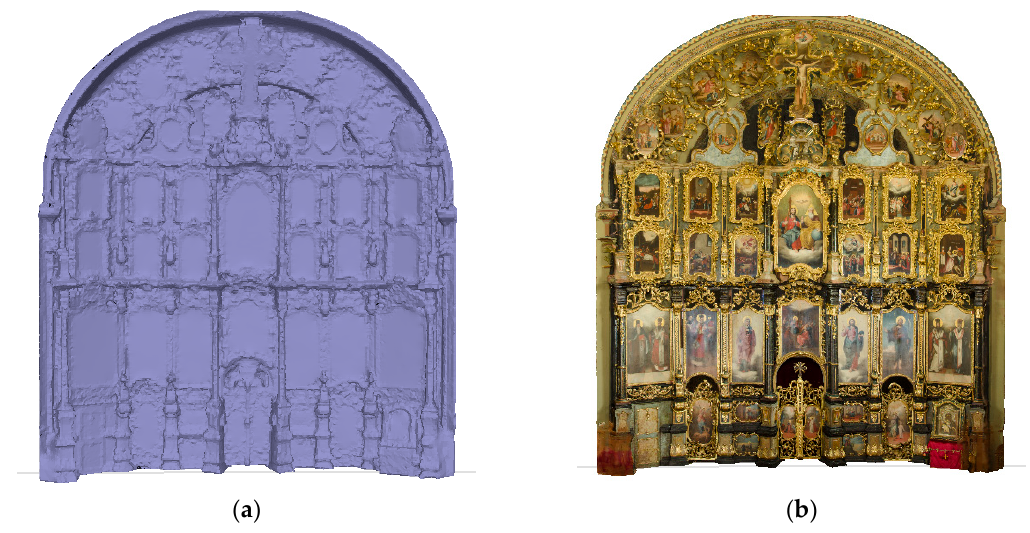
Figure 7. ( a ) Low-poly model with details projected from the high-poly model; ( b ) Low-poly model textured in Agisoft Metashape.